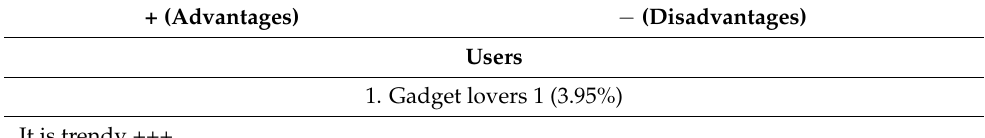
Table 3. Opinions and evaluations on electric bicycles among all types of users and non-users.